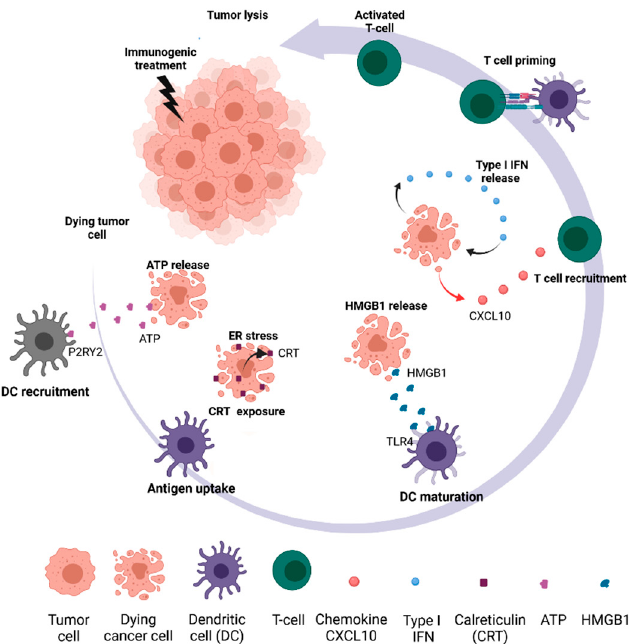
Figure 1. Molecular basis of immunogenic cancer cell death (ICD) (Inspired by Galluzzi et al. 2016 [59] and created with BioRender.com).